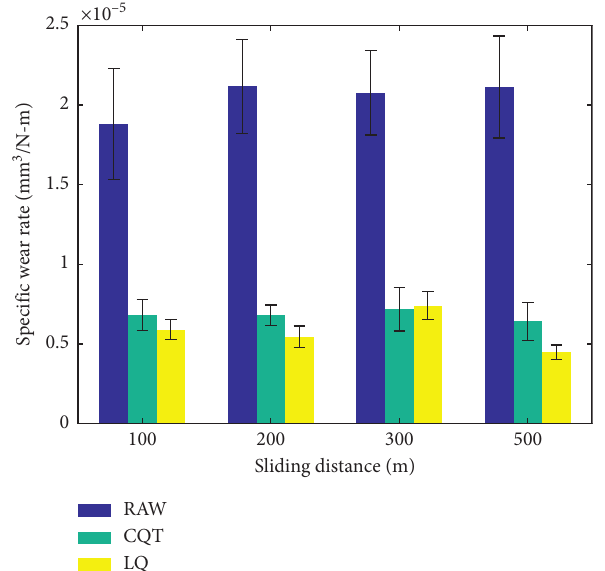
Figure 10: Specific wear rate and sliding distance for different testing conditions.